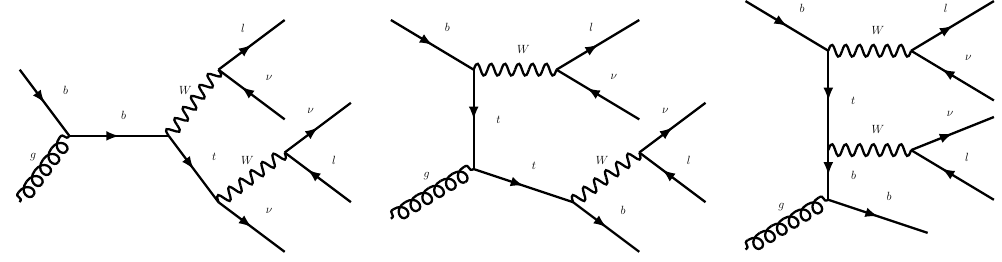
Figure 1 . Representative leading order SM diagrams for pp